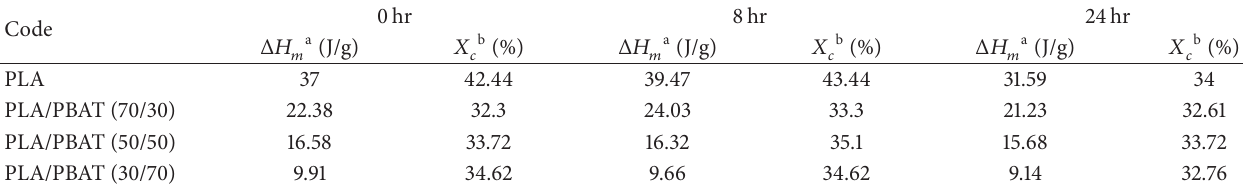
Table 3: The enthalpy and crystallinity of PLA/PBAT blends treated at 100 ∘ C for 8 and